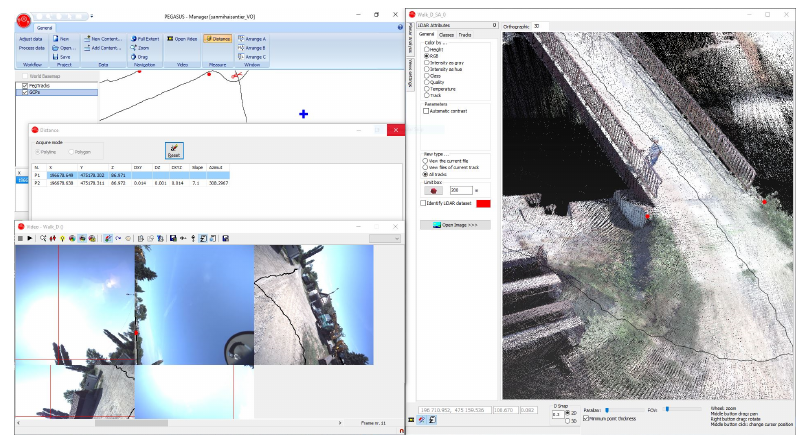
Figure 32. Adjustment on GCP No.1.